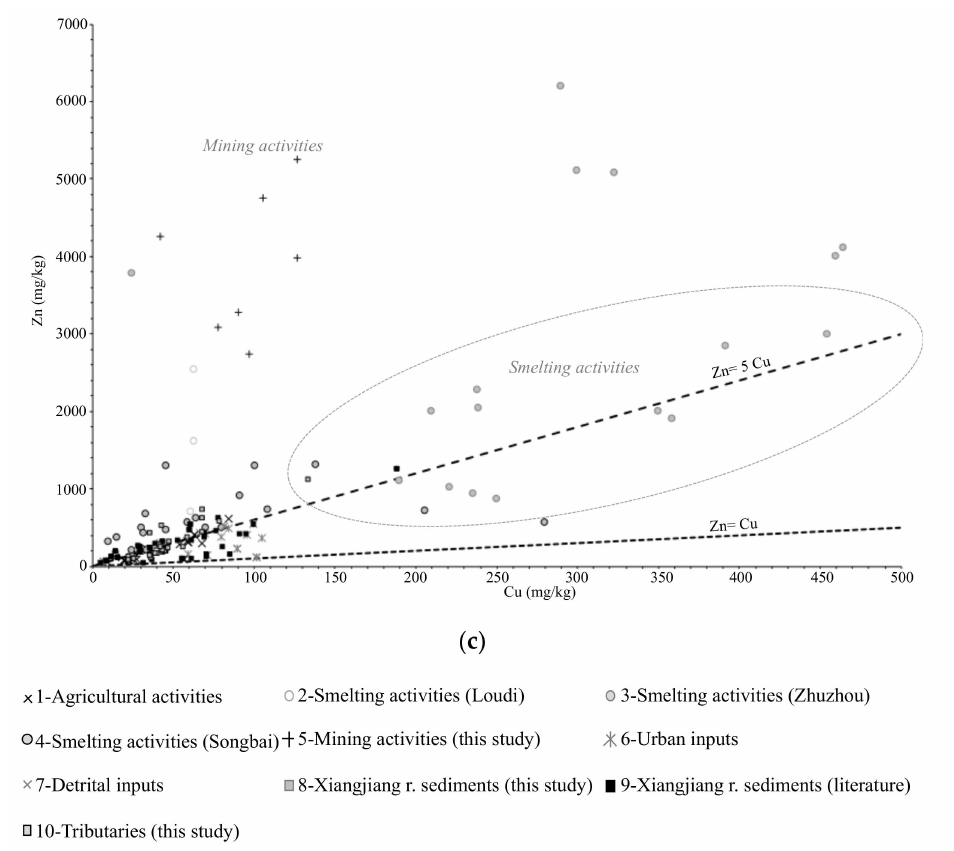
Figure 3. Principal component analysis biplot ( a ), Pb-Zn ( b ) and Cu-Zn scatterplots ( c ) for surface sediments from the Xiangjiang River basin ( n = 149). Same legends for Figure 3a–c. See text for sample category definition and Table S1a,b for sample